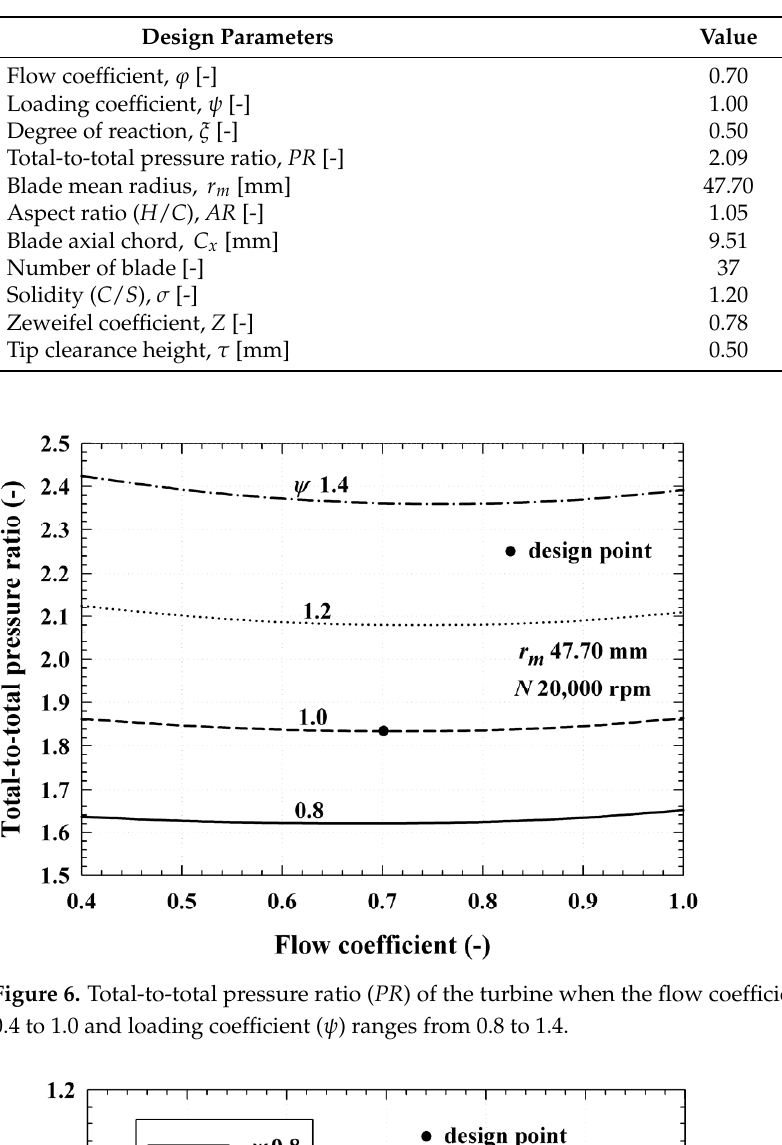
Figure 8. Total-to-total isentropic efficiency of the turbine ( 𝜂 (cid:3047) ) when the flow coefficient ( 𝜑 ) ranges from 0.4 to 1.0 and loading coefficient ( 𝜓 ) ranges from 0.8 to 1.4.